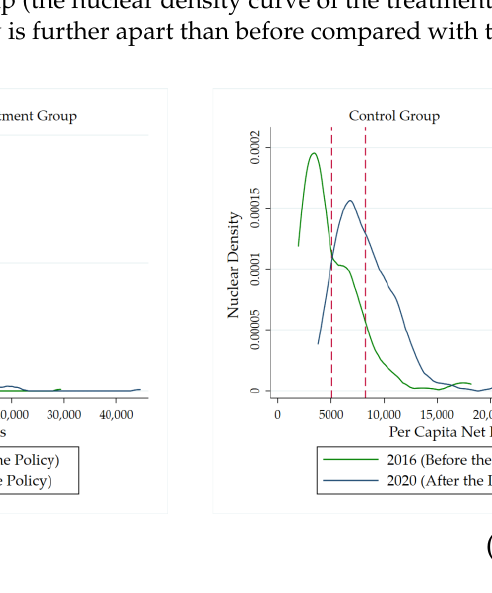
Figure 2. Nuclear Density of per Capita Net Income of Households in the Control Group and the Treat Group Before and After the Implementation of the Policy. ( a ) Tanglang Village Committee of Tanglang Township; ( b ) Dache Village Committee of Zehei Township.